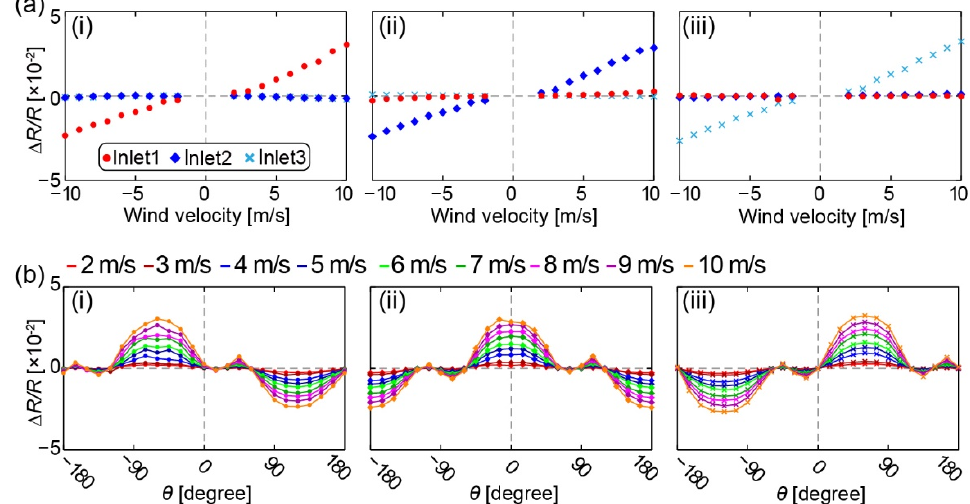
Figure 8. ( a ) Relationship between the wind velocity and the fractional resistance changes in three DP sensors when the corresponding inlet is on the axis of the wind tunnel: ( i ) inlet 1, ( ii ) inlet 2, and ( iii ) inlet 3. ( b ) Relationship between the wind direction and the fractional resistance changes for each inlet.